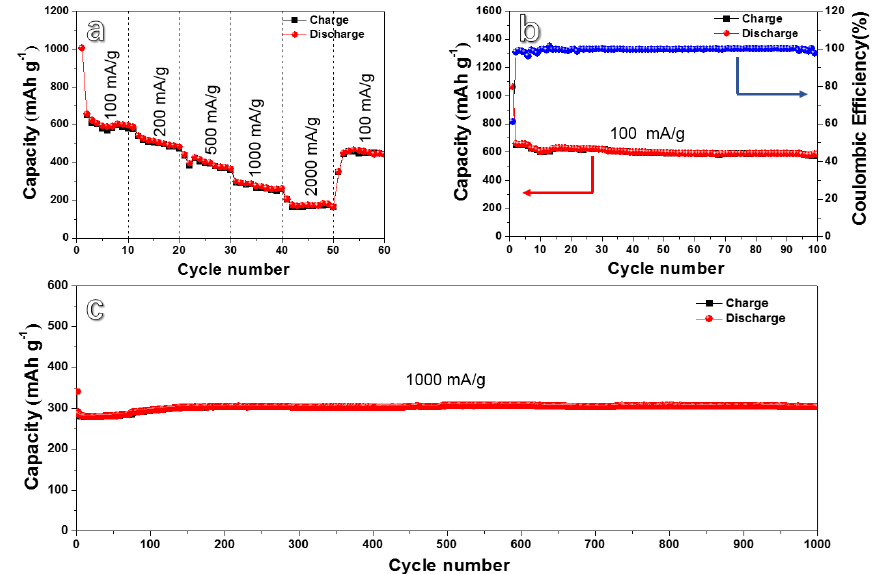
Figure 5. ( a ) Rate performance at various current densities and cyclic performance of HPC at current density of 100 mA g −1 ( b ) and 1000 mA g −1 ( c ).